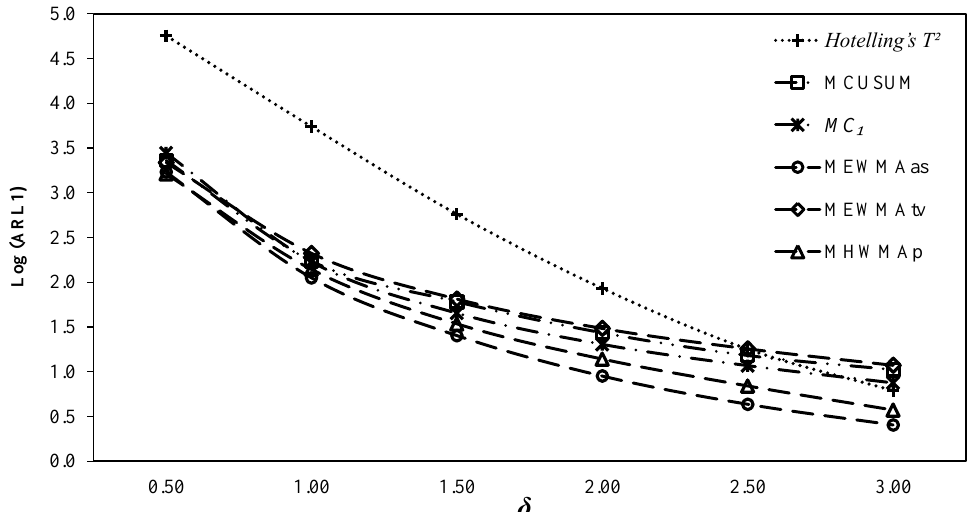
Figure 1. Average run length (ARL) comparisons for 𝑝 = 2 . MEWMA, multivariate exponential weighted moving average; MHWMA, multivariate homogeneously weighted moving average; MCUSUM, multivariate CUSUM.